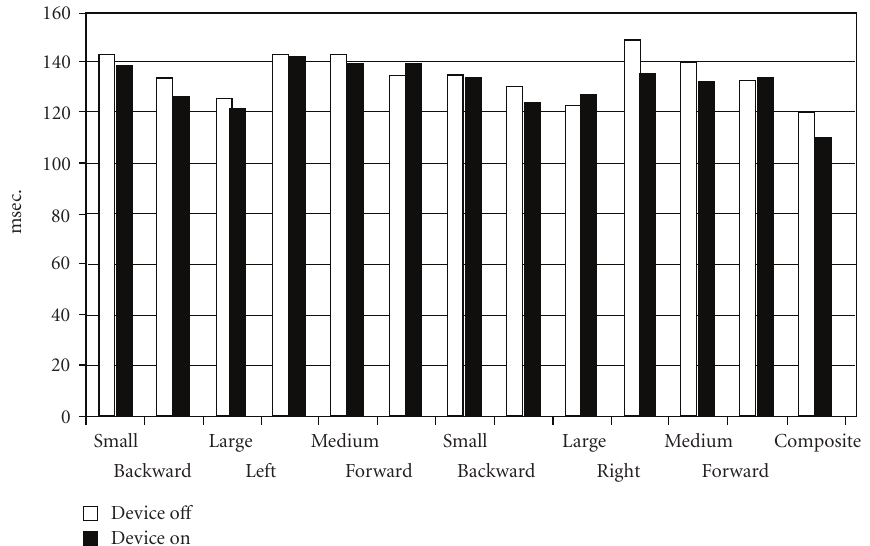
Figure 5: Latency periods exhibited by the overall test population for forward and backward translational movements (separate data for each foot) and for small, medium, and large movements of the force-plate.